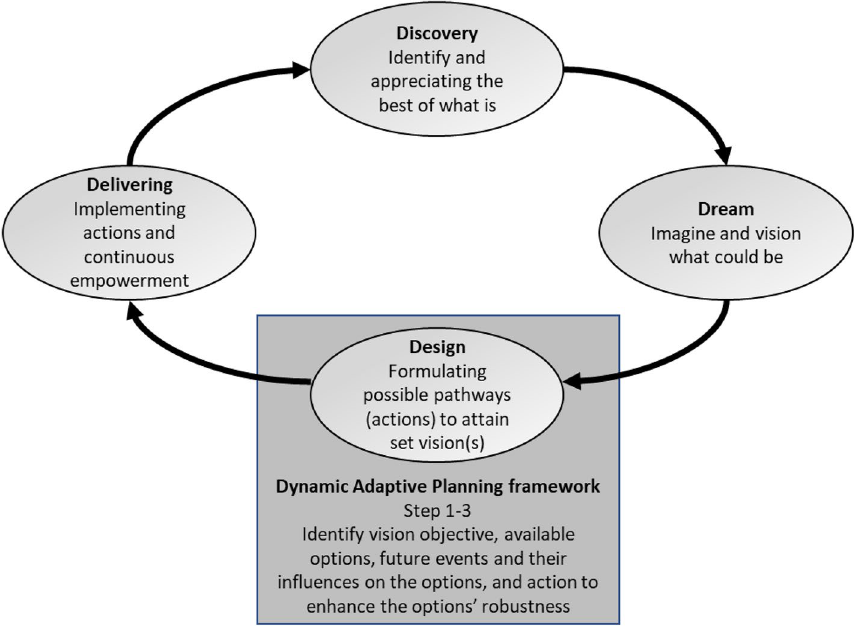
Figure 1. Robust and generative visioning framework, Adapted from 47